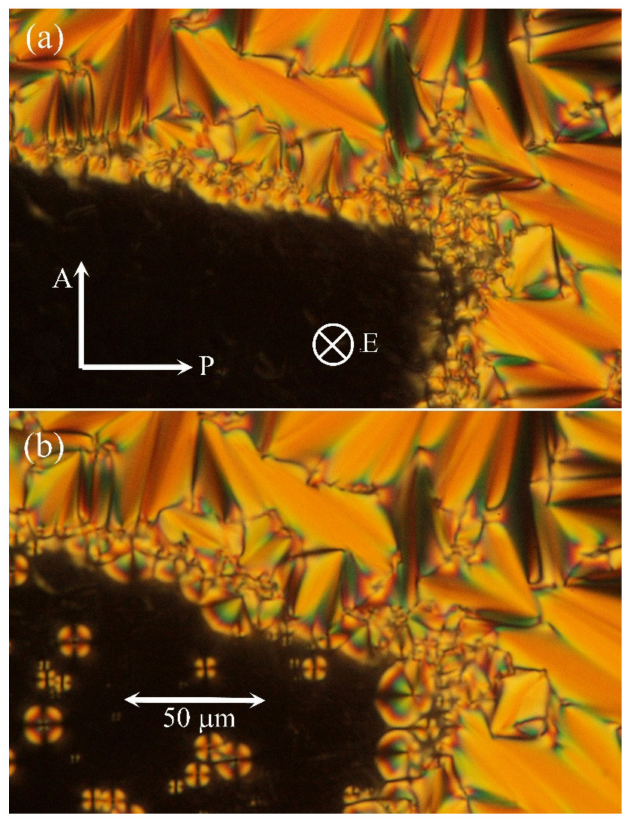
Figure 2. Microphotographs of the studied hybrid system in a commercial HG cell, thickness—5 µ m, in the SmA phase at T = 98 ◦ C ( a ) under the applied electric field, E, with the intensity of 50 V/ µ m in the perpendicular direction, and ( b ) after switching off the field after 10 seconds.